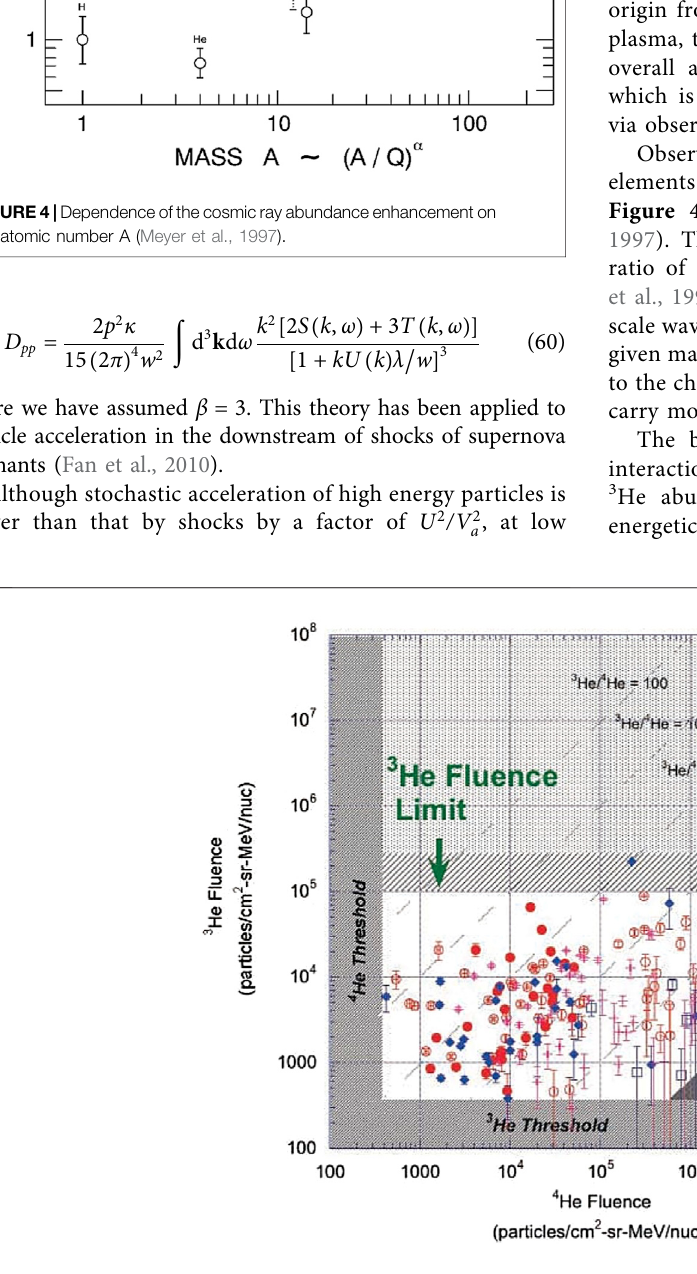
Frontiers in Astronomy and Space Sciences |